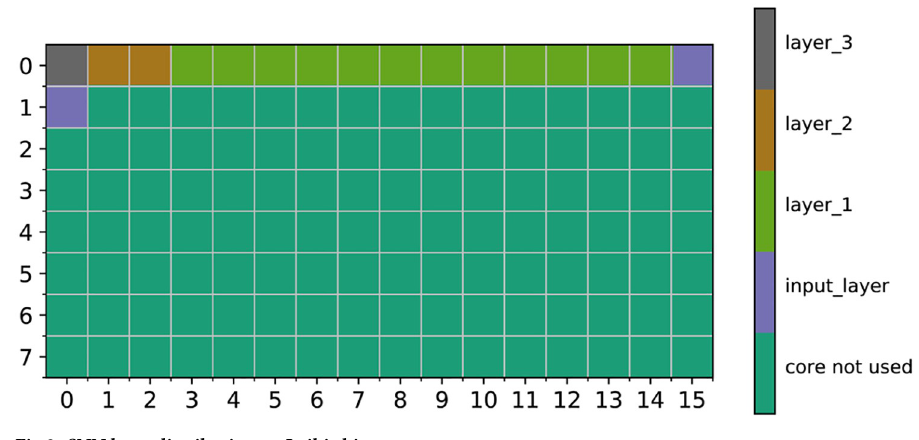
Fig 3. SNN layer distribution on Loihi